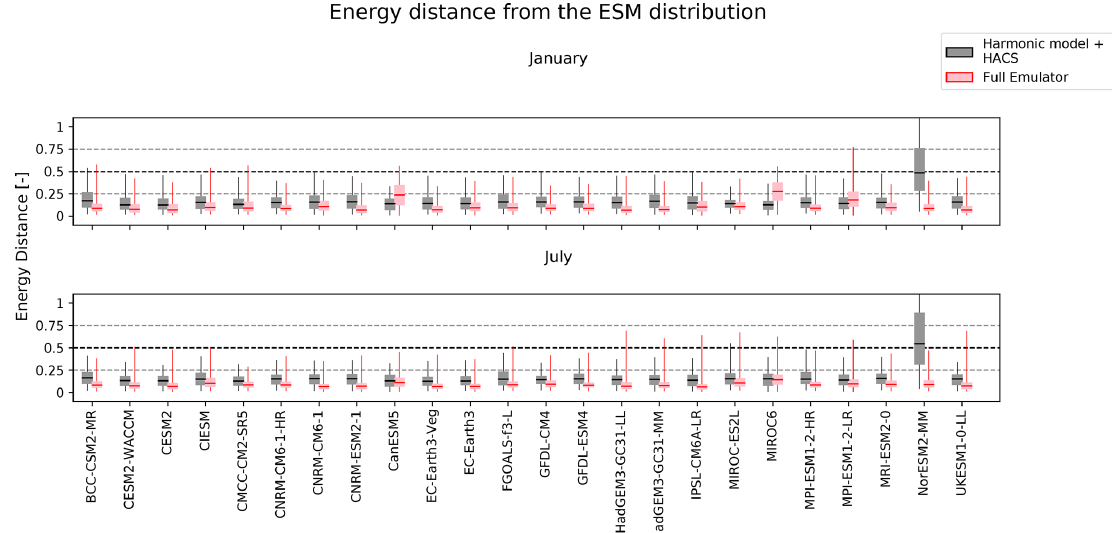
Figure E2. Comparison of the performance of the harmonic model + physically informed HACS model to that of the full emulator for January and July of all CMIP6 models. The energy distance from the actual model test runs is considered, where 0 indicates the best performance. Boxplot whiskers indicate 5th and 95th quantiles.